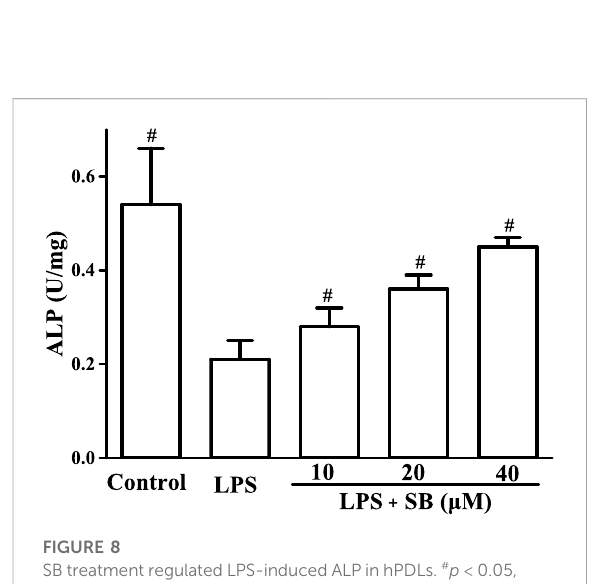
FIGURE 8 SB treatment regulated LPS-induced ALP in hPDLs. # p < 0.05, compared to the LPS group.